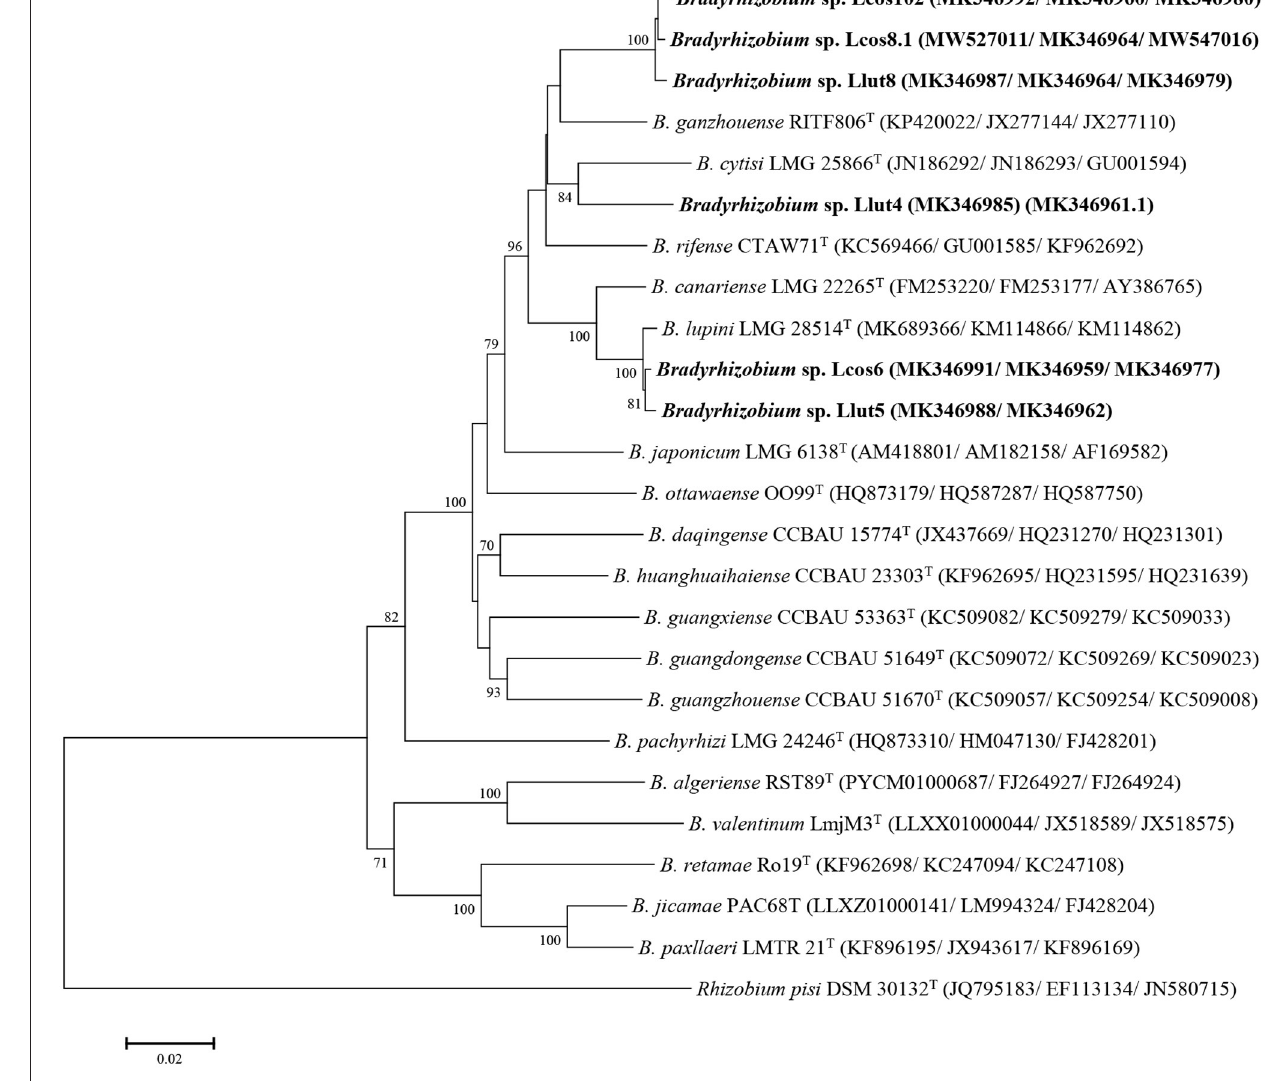
FIGURE 2 | Maximum likelihood phylogenetic tree based on concatenated gyrB + recA + glnII sequences (1,430 nt) of strains from nodules of L. cosentinii and L. luteus and phylogenetically related species within the genus Bradyrhizobium . The analysis was based on 1,405 nucleotides. Isolates are denoted in bold. Bootstrap values are indicated as percentages derived from 1,000 replications. Values lower than 50 are not shown. Bar, 2 nucleotides substitution per 100 nucleotides. The tree is rooted with Rhizobium pisi DSM 30132 T